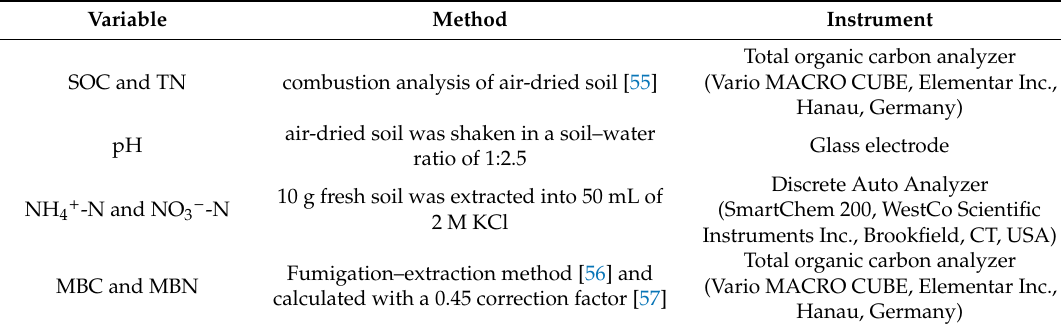
Table 2. Laboratory methods to measure soil physical, chemical, and microbial properties.